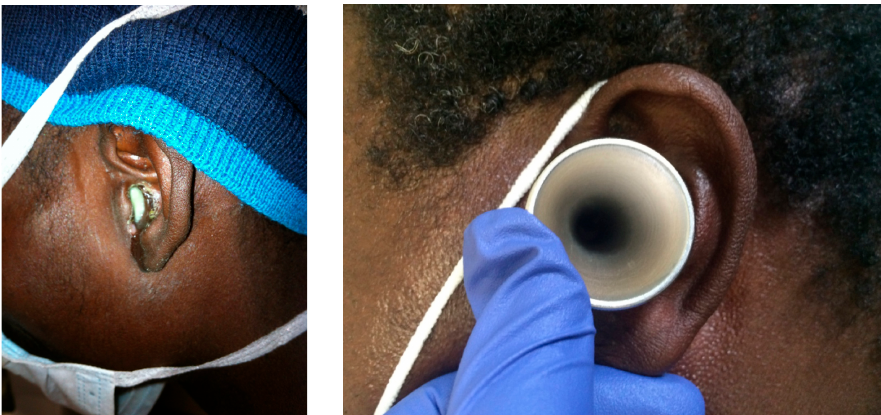
Figure 1. Chronic Suppurative Otitis Media (CSOM) presentation and collection of samples. Example of purulent drainage visualized in the external auditory canal (EAC) of a patient with CSOM. Samples were obtained by suctioning the most superficial material as needed, cleaning the external ear and entrance of the EAC with an alcohol swab, and then obtaining the culture from an area of visualized purulence through a sterile speculum.